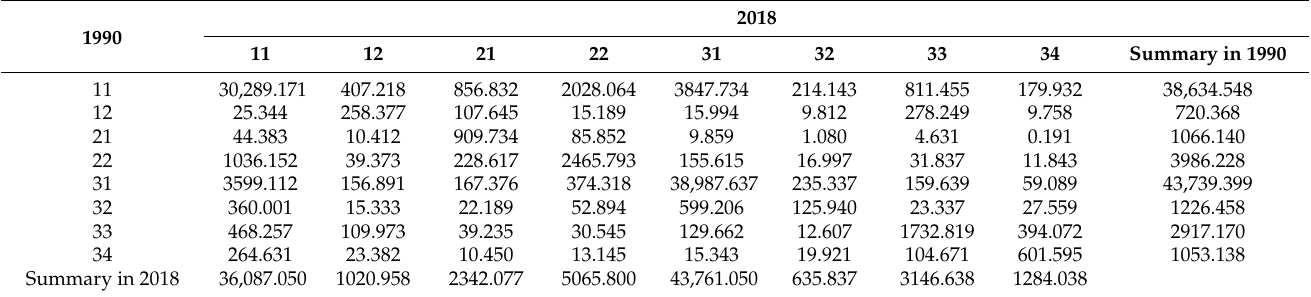
Table 5. Transition matrix of land-use types in the central and southern Liaoning urban agglomeration 1990–2018 (km 2